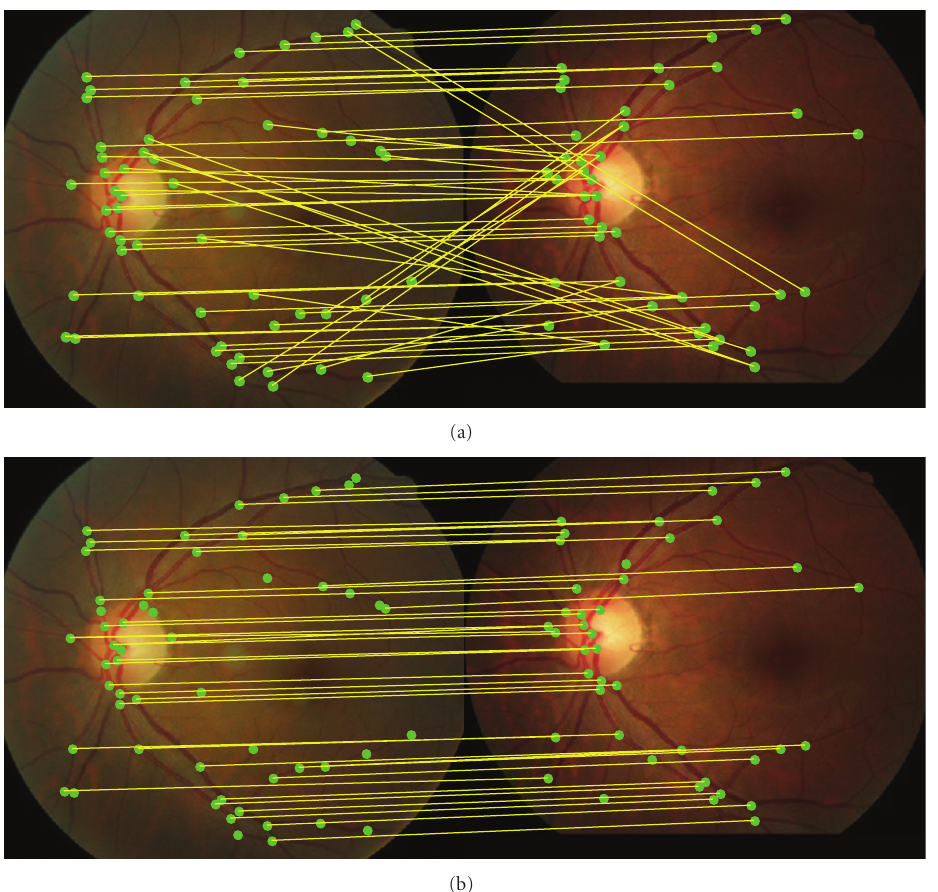
Figure 6: Correspondences between two retinal feature sets after graph matching. (a) Without STRUCT-SAC. (b) With